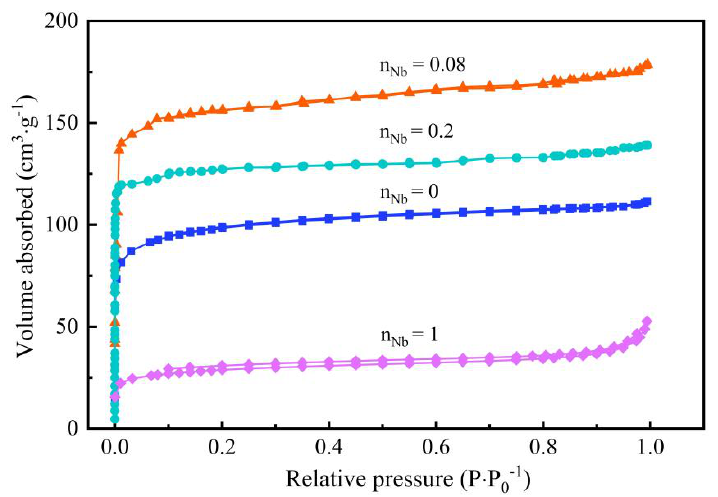
Figure 11. N 2 adsorption–desorption isotherms of Nb/SiO 2 materials doped with various n Nb cal- cined at 400 °C.